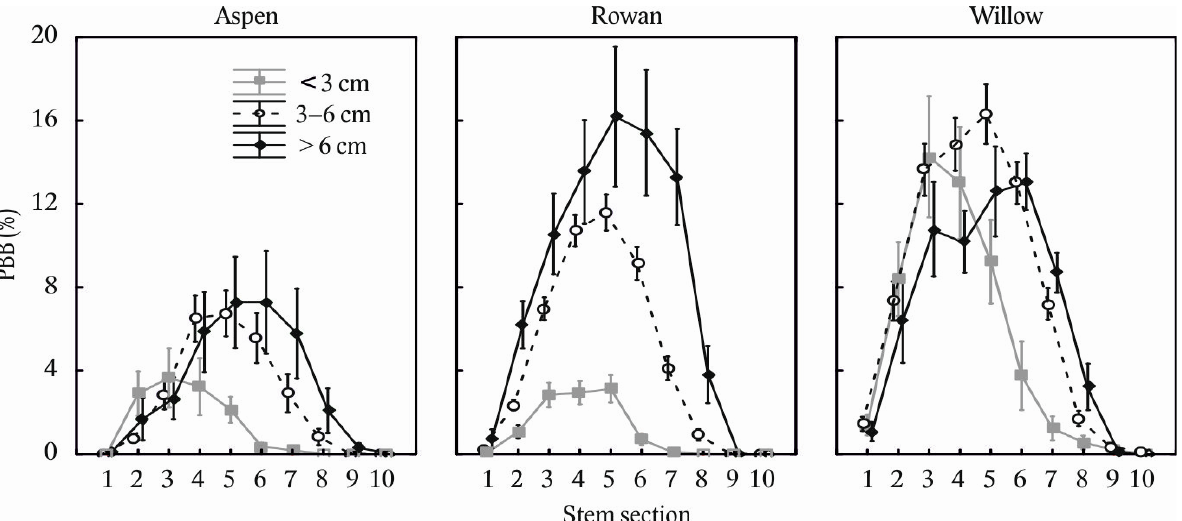
Figure 6. Stem bark browsing on common aspen ( Populus tremula L.), common rowan ( Sorbus aucuparia L.), and goat willow ( Salix caprea L.) considering diameter classes of stems and stem sections. Stem browsing is expressed on relative basis (i.e., proportion of browsed bark mass to full bark mass potential). The error bars indicate standard errors. The stem sections are coded as 1: 0–25 cm, 2: 26–50 cm, 3: 51–75 cm, 4: 76–100 cm, 5: 101–125 cm, 6: 126–150 cm, 7: 151–175 cm, 8: 176–200 cm, 9: 2: 201–225 cm, and 10: 226–250 cm from the ground level.